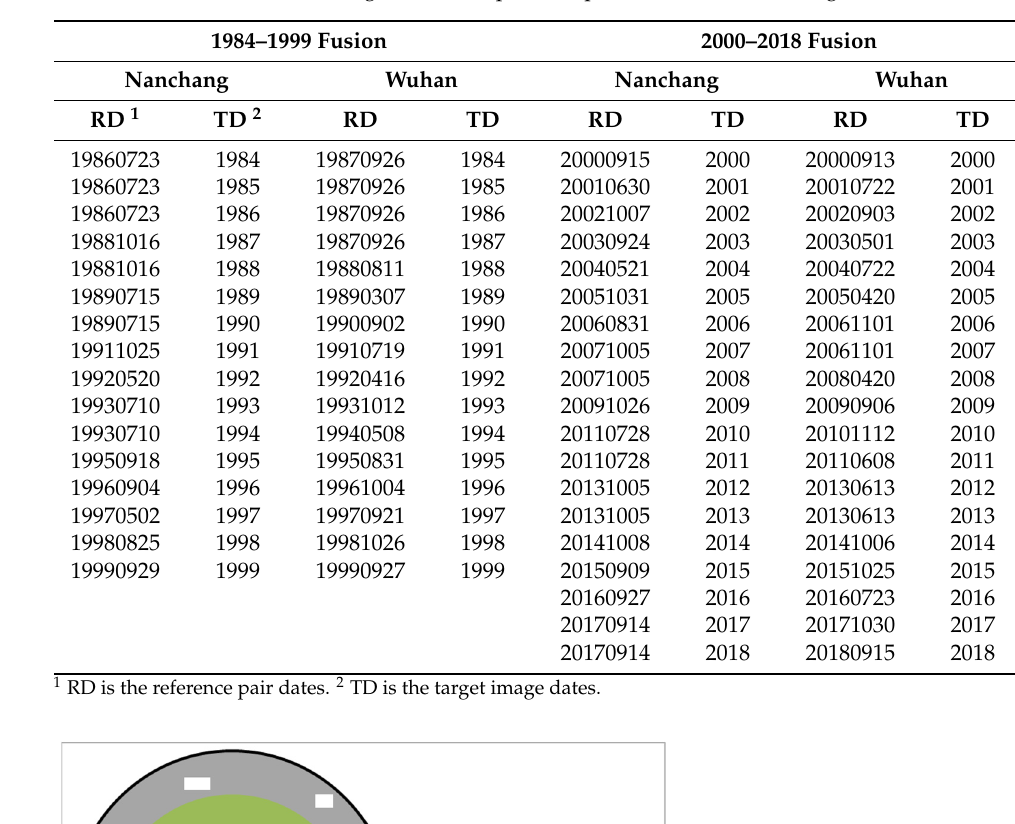
Table 2. Reference LSTs and target LSTs for spatiotemporal fusion in Nanchang and Wuhan.